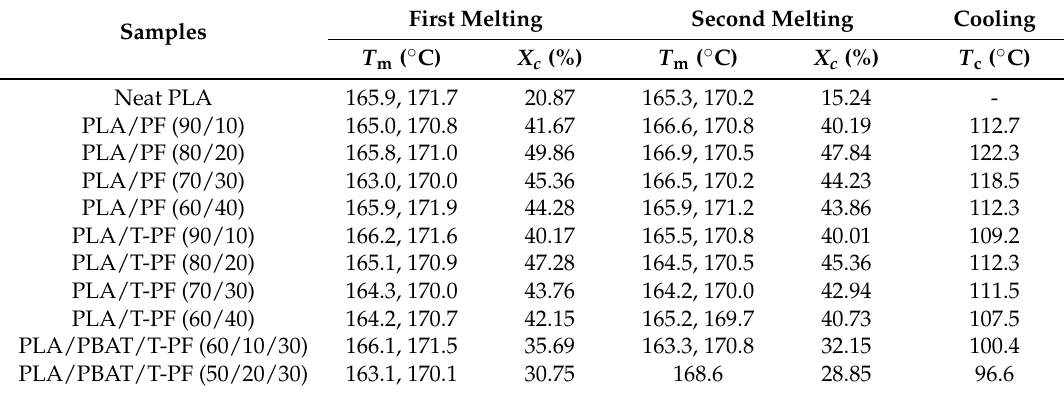
Table 2. Differential scanning calorimetry parameters of isothermally crystallized samples.